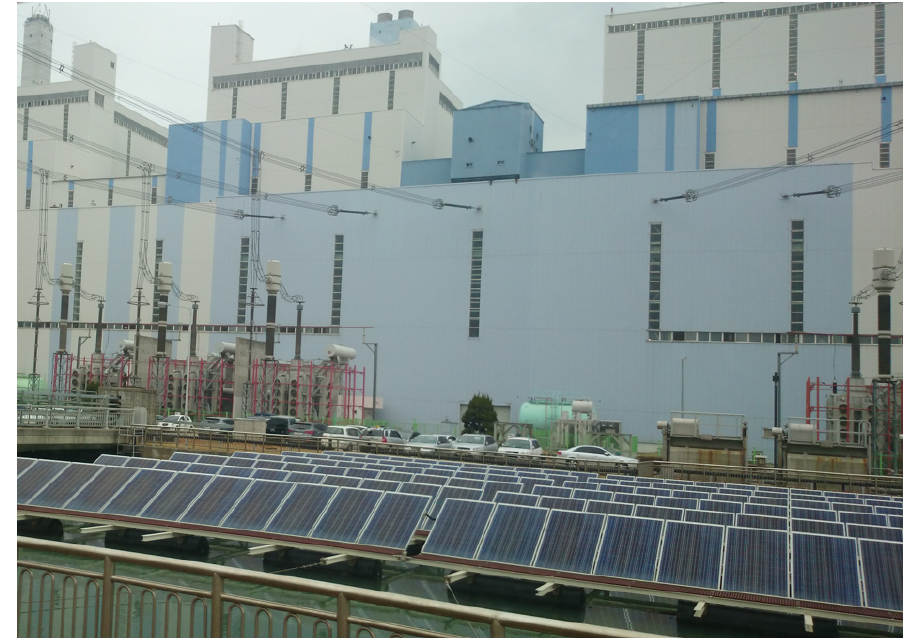
Figure 5. Part of the infrastructure of the Dangjin power